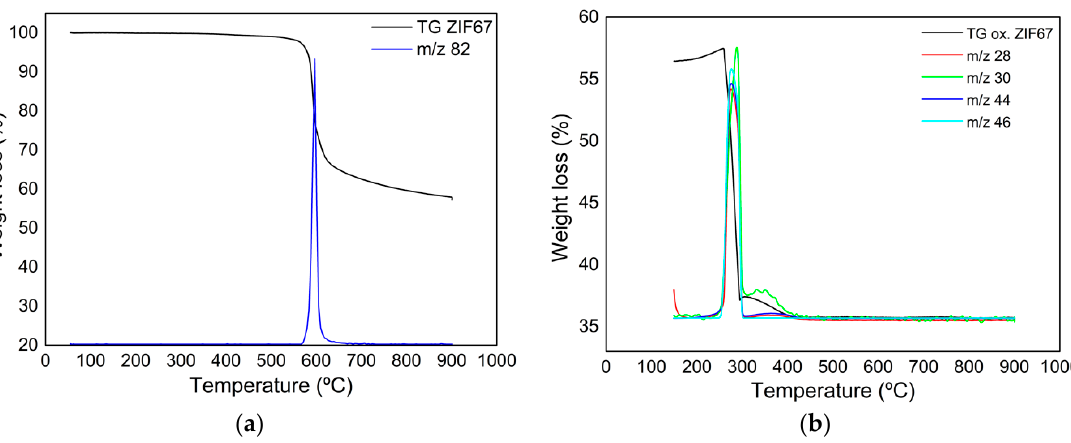
Figure A1. 1 H-NMR spectra of the reaction crude.